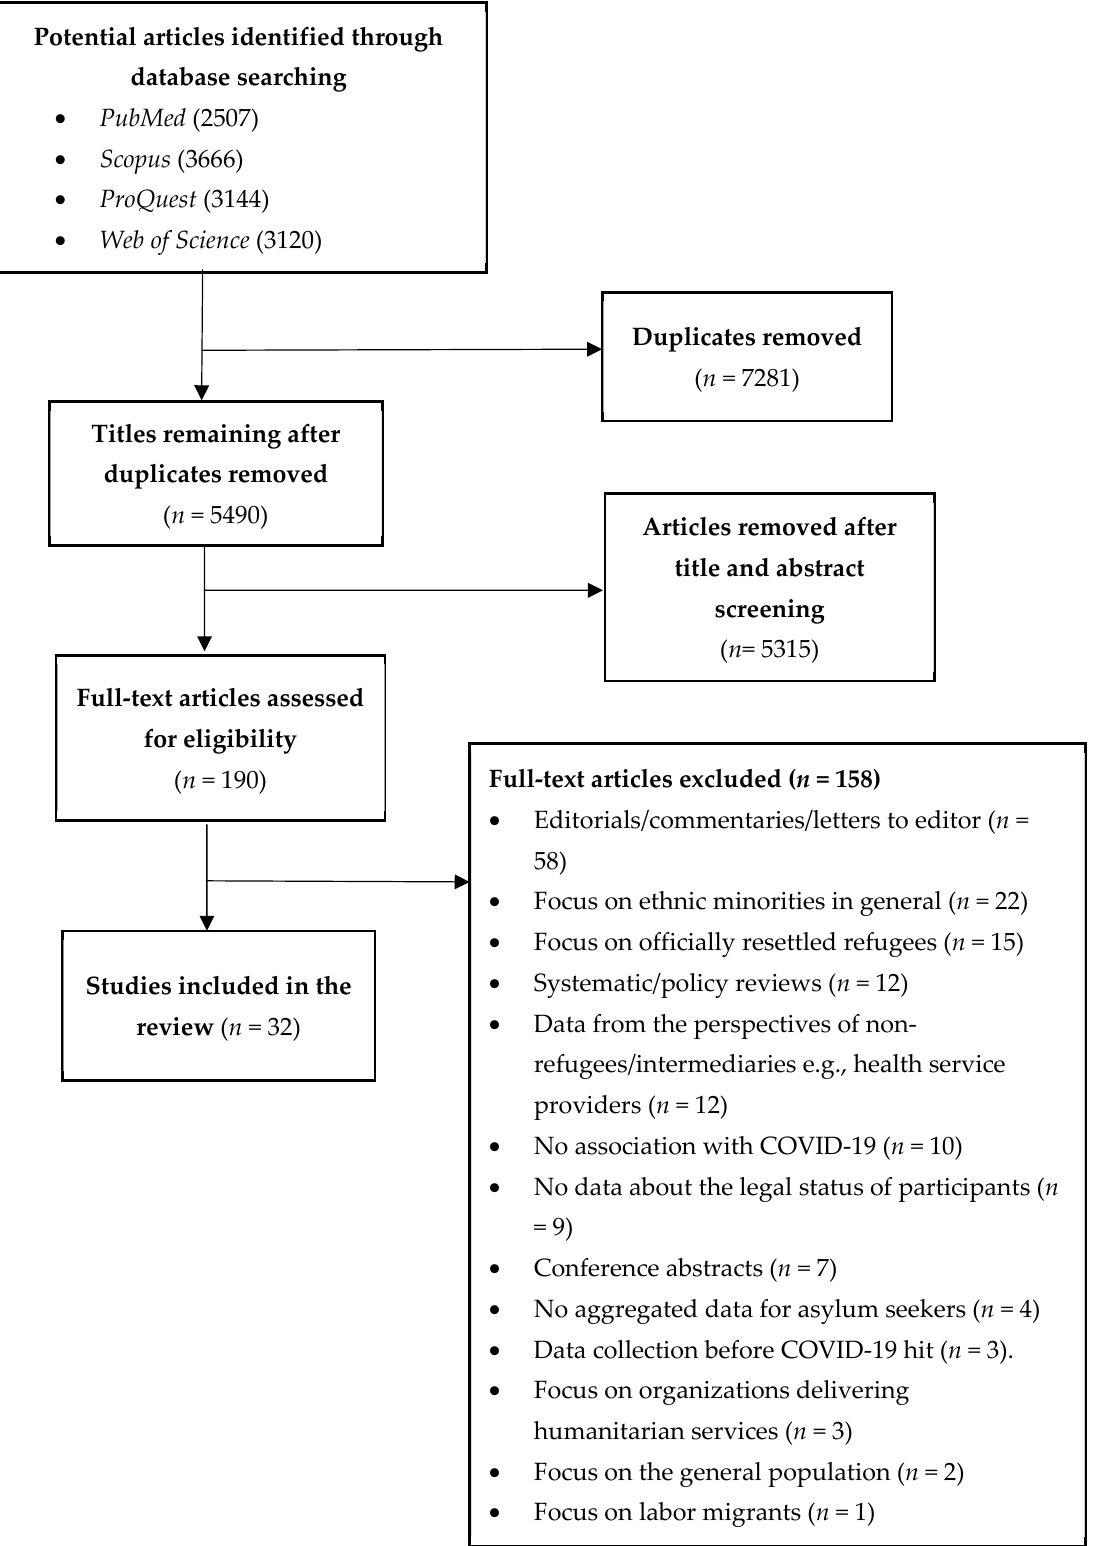
Figure 1. PRISMA flow chart of scoping review process and sampling.